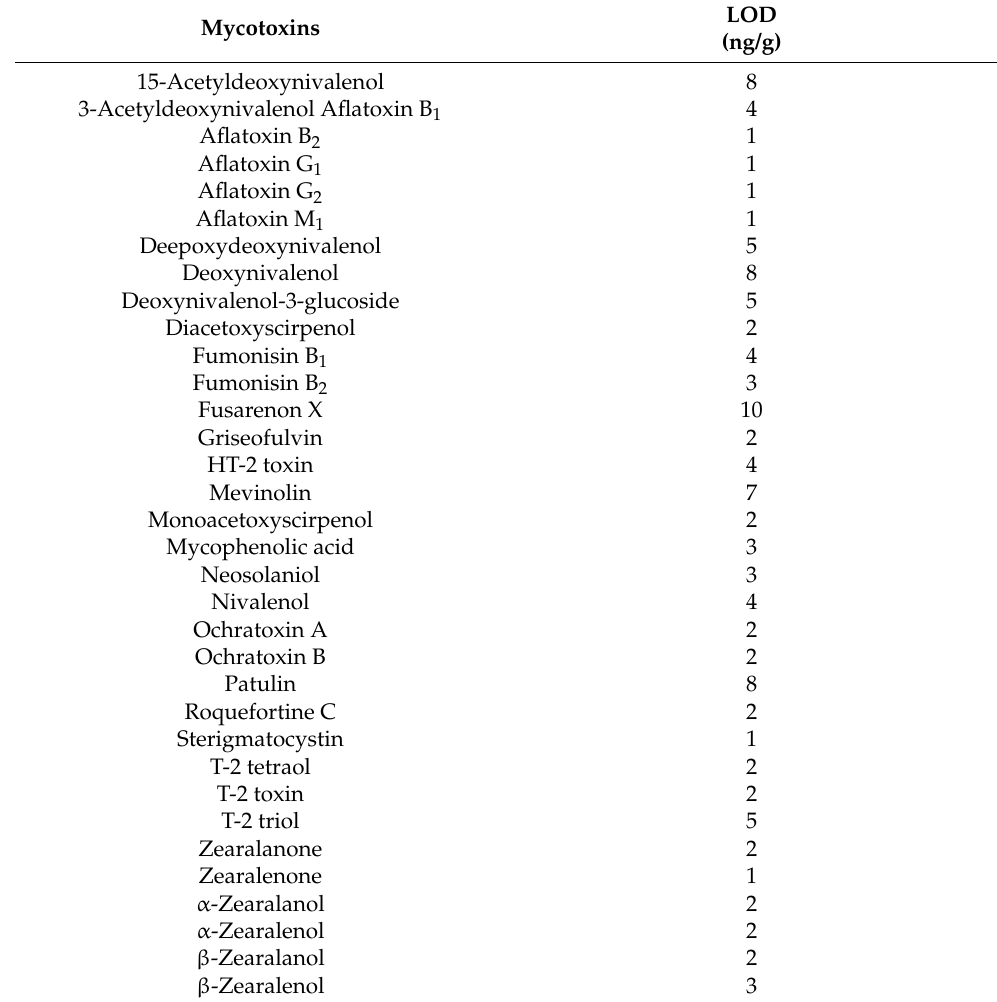
Table 1. LOD values for the analyzed